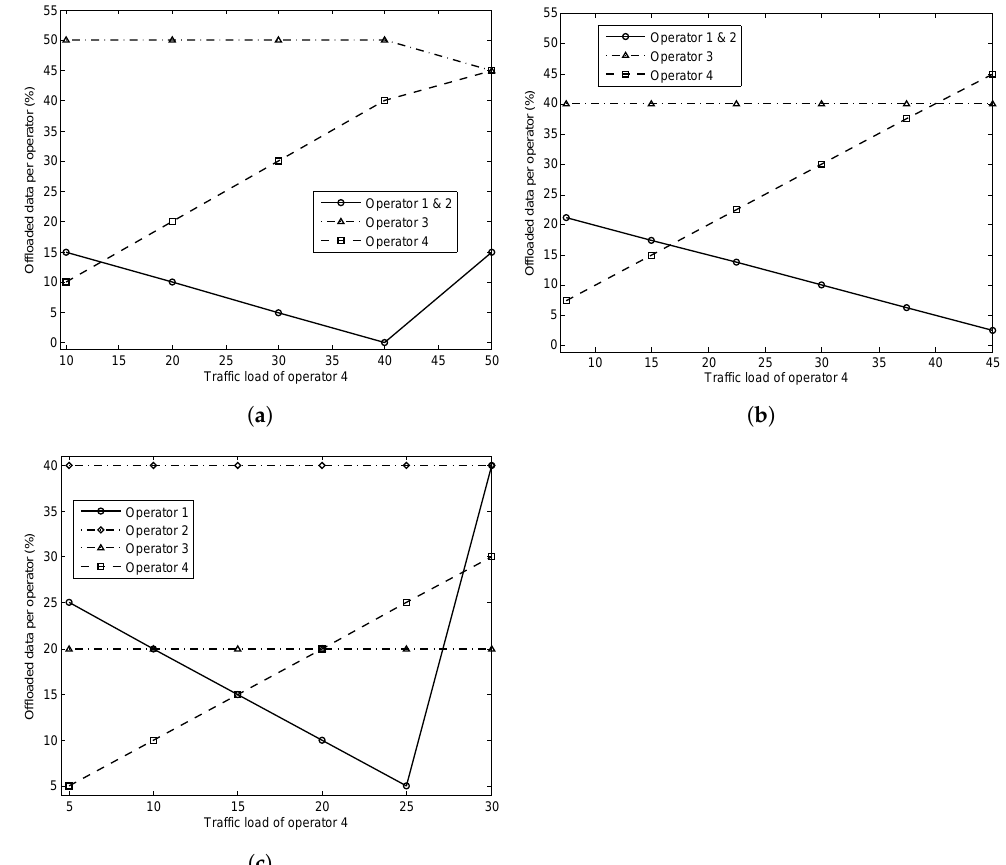
Figure 6. Impact of network traffic on the offloaded data of each operator. ( a ) Scenario 1—High traffic; ( b ) Scenario 2—Medium traffic; ( c ) Scenario 3—Low